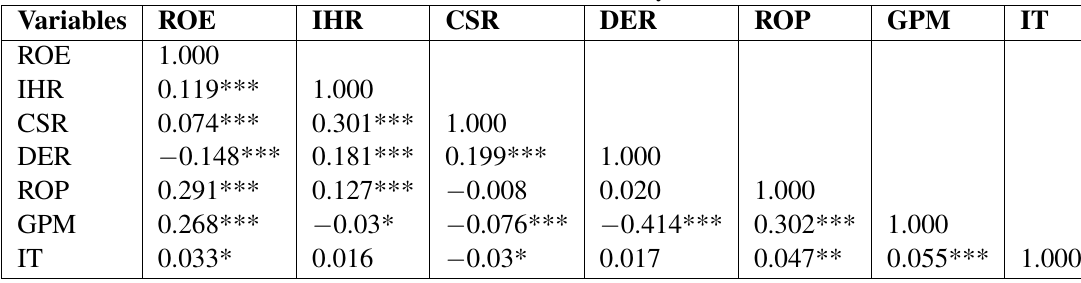
Table 5 Correlation